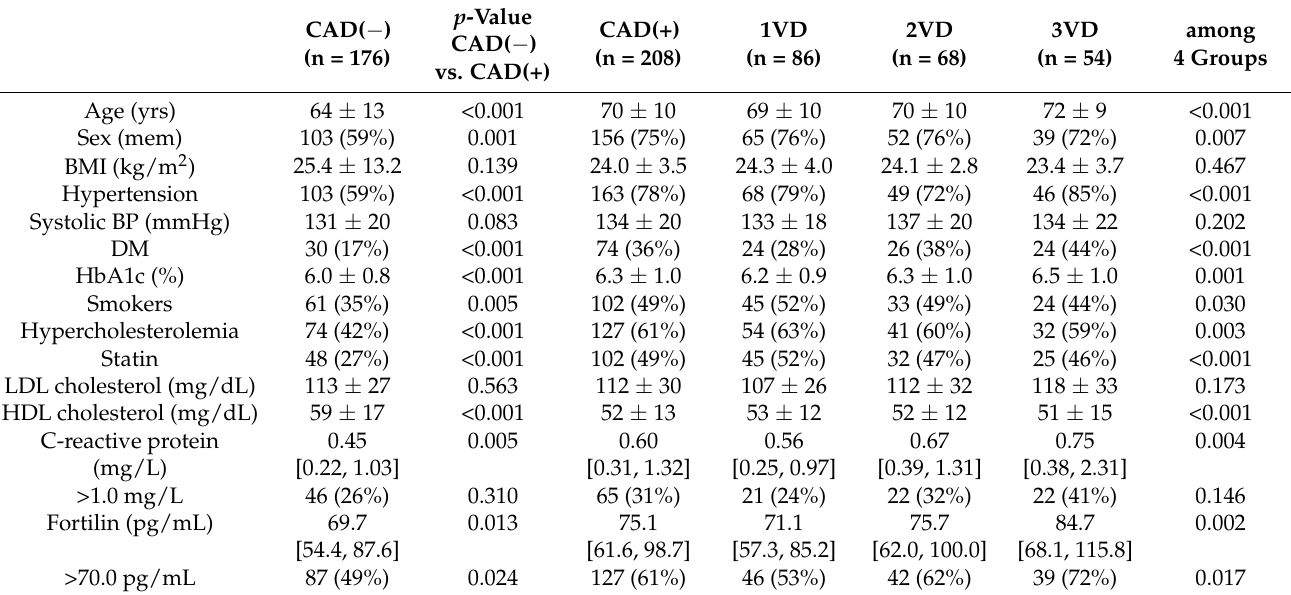
The data show mean ± SD or number (%), apart from CRP and fortilin, which are shown as median and interquartile range.